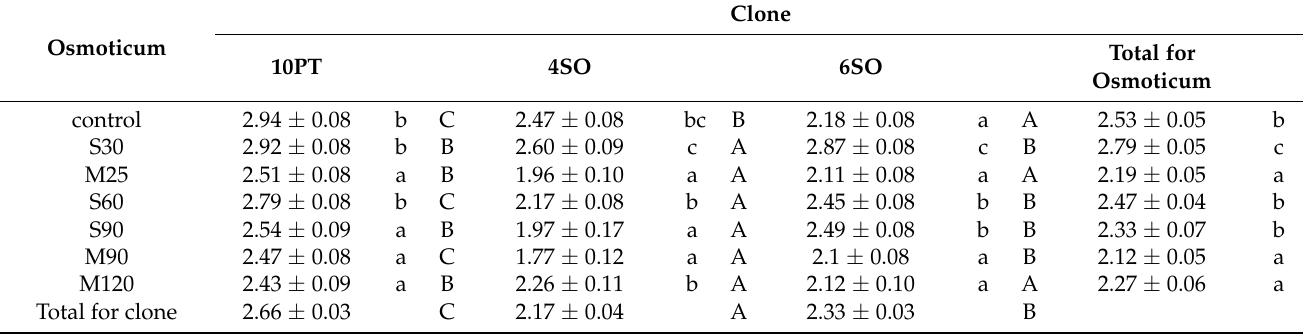
Table 8. Mean ± SE total shoot length TSL (cm) of R. pseudoacacia clones (10PT, 4SO, 6SO) for different osmotic treatments. Different treatments are denoted by the water potential ( Ψ ) and the osmotic agent and its concentration in the medium and denoted as: “control”—medium without